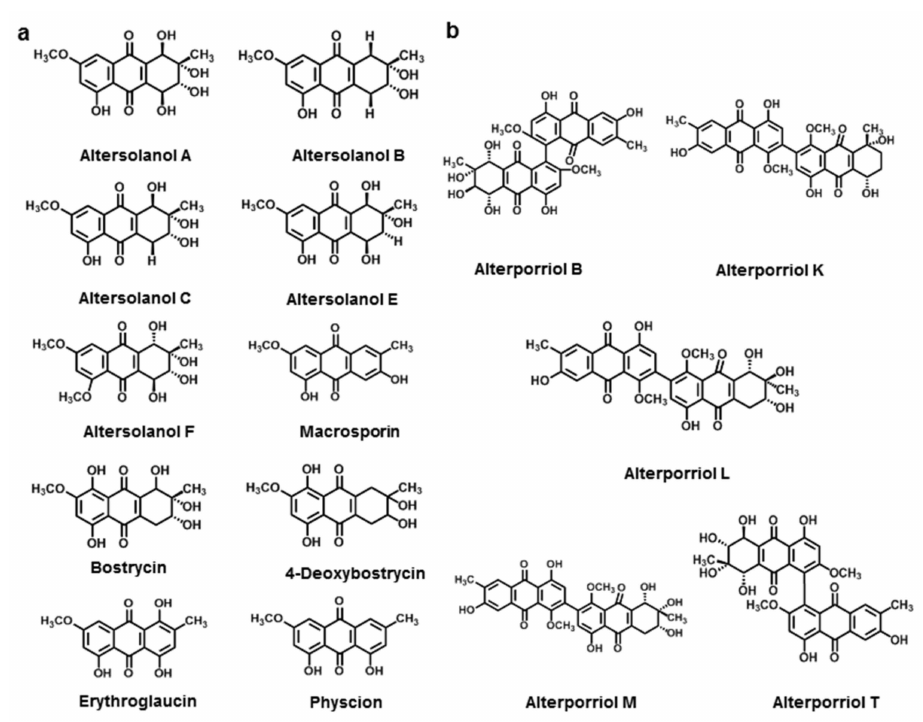
Figure 8. Chemical structures of Alternaria NHSTs belonging to anthraquinone ( a ) and bianthraquinone ( b )